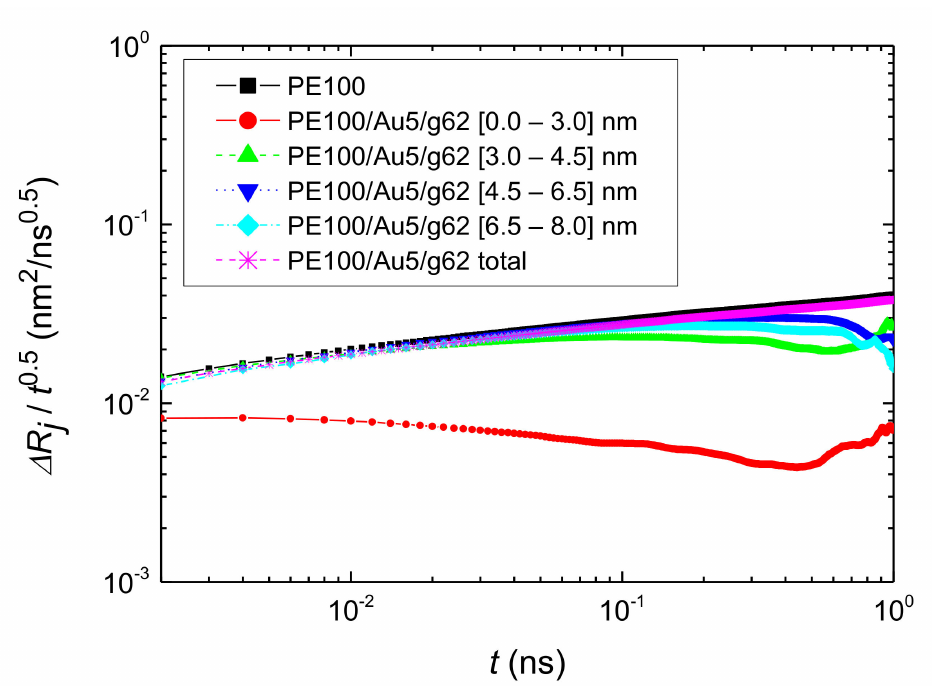
Figure 10. Segmental MSD of PE chains along r (distance from the center of the gold NP), ∆ Rj , scaled with t 0.5 Data for the PE100/Au5/g62 system, for various spherical shells, and the total MSD of the PE100 and PE100/Au5/g62 systems are